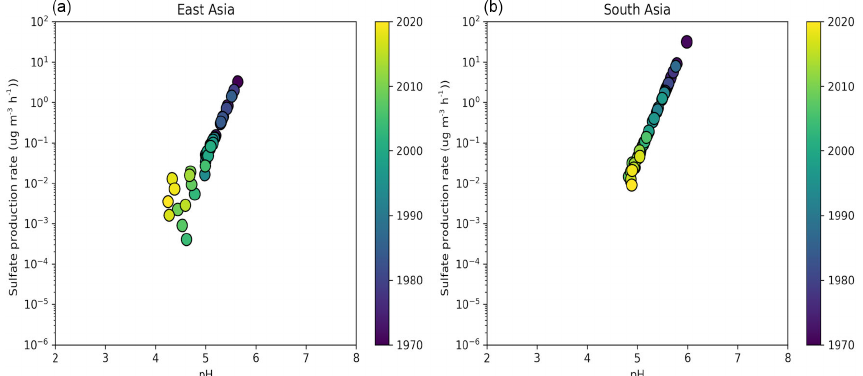
Figure 5. Time evolution of the sulfate production rate on aqueous particles from the SO 2 + O 3 multiphase chemistry reaction as a function of aerosol particle pH over East Asia (a) and South Asia (b) during the period